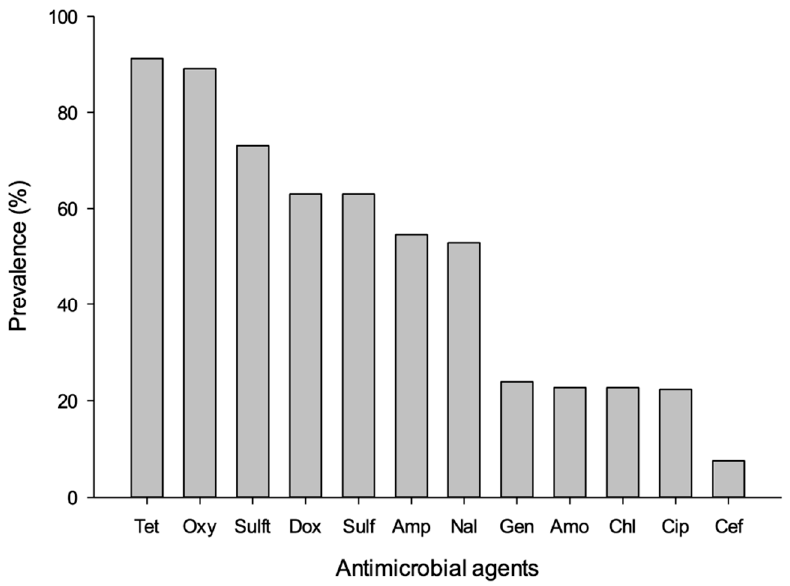
Figure 1. Prevalence of antimicrobial-resistant Escherichia coli isolated from poultry farms collected from Kelantan, Terengganu, and Pahang poultry operations. Data are the number of samples (n = 371). Tet: Tetracycline; Oxy: Oxytetracycline; Sulft: Sulfamethoxazole/trimethoprim; Sul: Sulfamethoxazole; Dox: Doxycycline; Amp: Ampicillin; Nal: Nalidixic acid; Chl: chloramphenicol; Gen: Gentamycin; Cip: Ciprofloxacin; Amo: amoxicillin and Cef: cefoxitin.